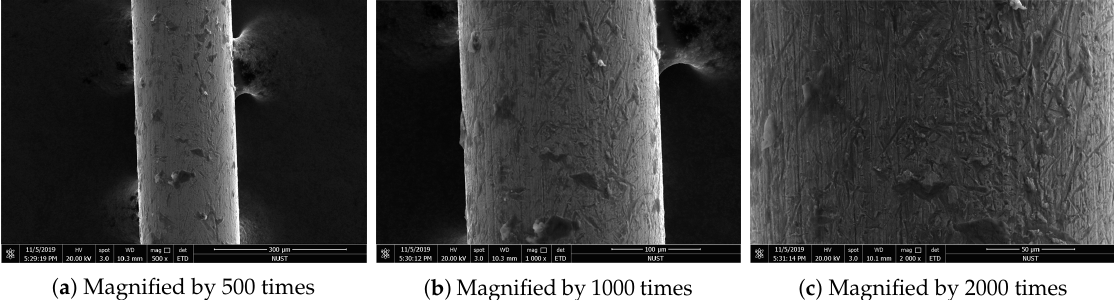
Figure 12. SEM images for steel fiber surface after complete pullout.